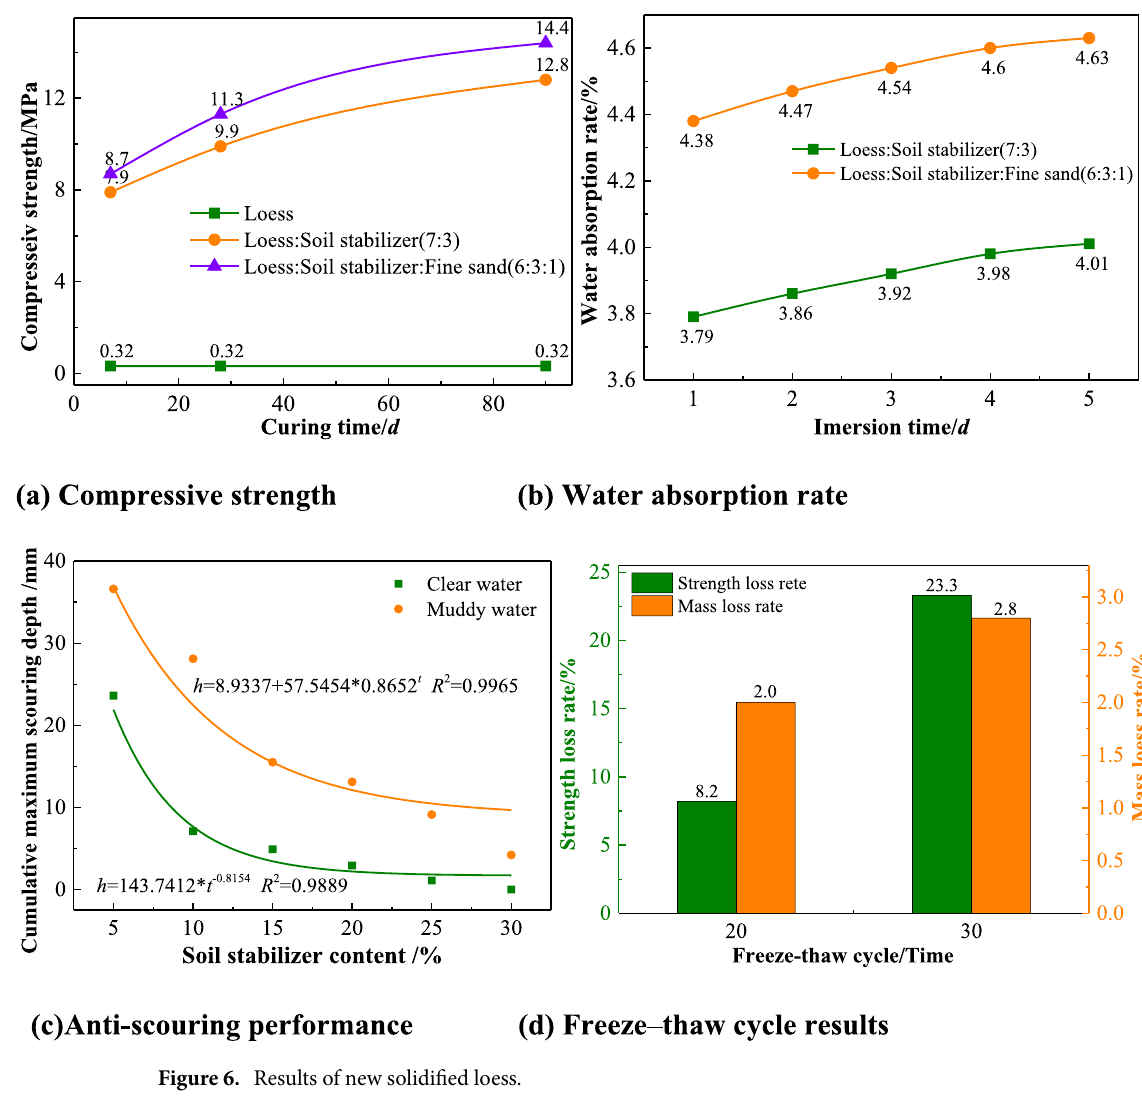
Figure 6. Results of new solidified